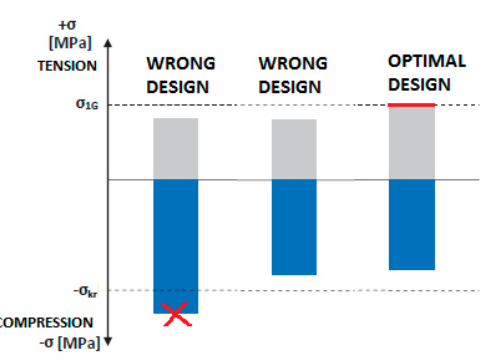
Fig. 7. A comparison of unsafe, inefficient and optimal